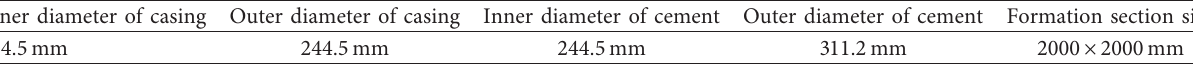
Figure 4: Finite element model of a thermal recovery wellbore. Table 1: Geometric dimensions of finite element models.